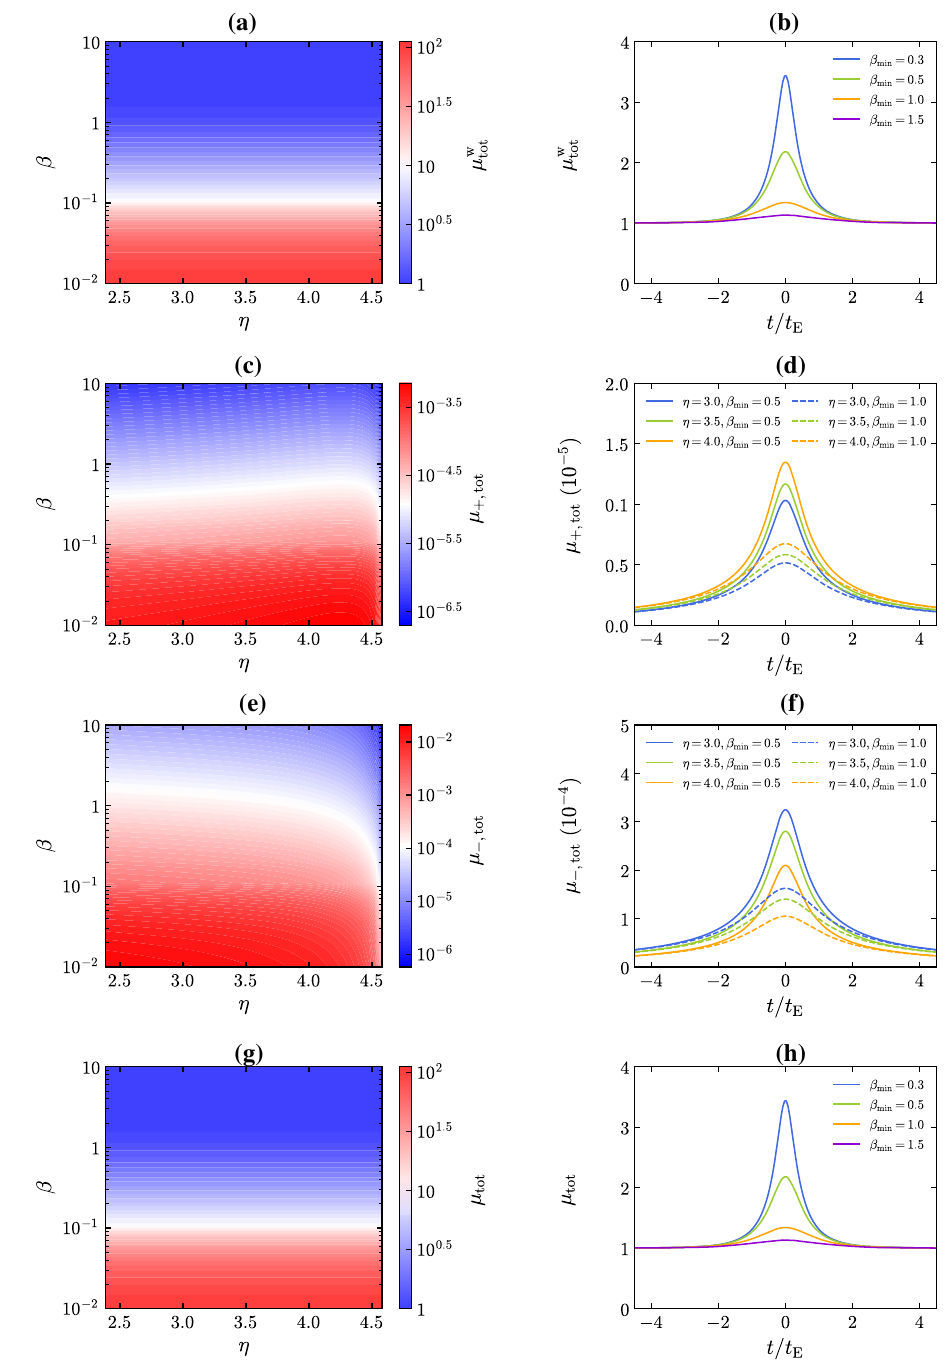
domain of (η, β) (left column) and their time evolution dur- ing crossing the Einstein ring (right column). As displayed in Fig. 8a, the deviation of centroid shift caused by the outer rel- ativistic images δ w , + increases with η and its biggest value is about 1 . 6 × 10 − 3 µ as which is far beyond the reach of current technology. Figure 8b shows some time evolution of δ w , + on the time domain. The difference between the light curves with the same η but different β becomes distinct only when − 2 t E < t < 2 t E . For a given β , a bigger η can give